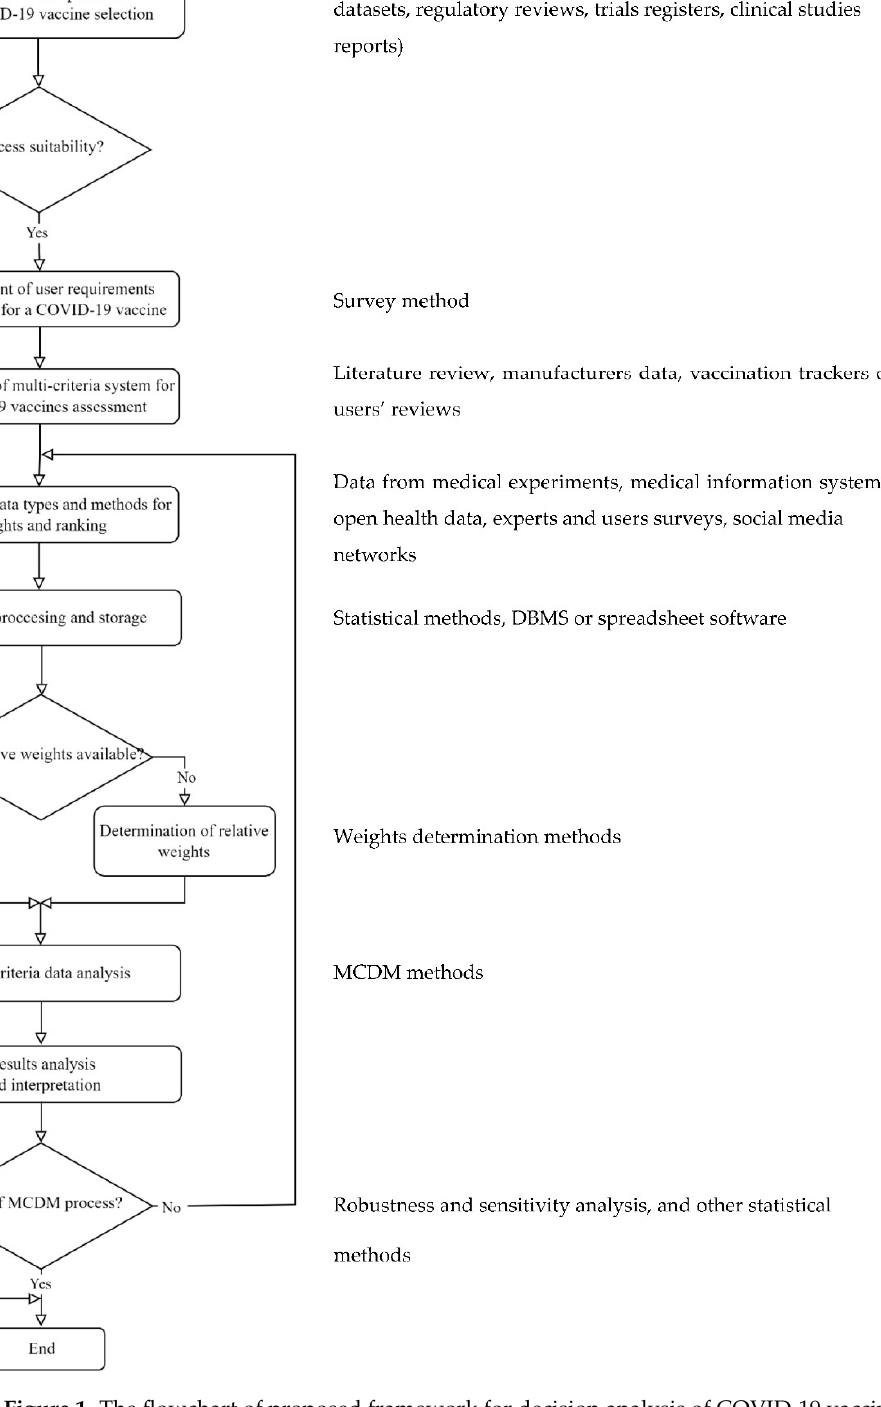
Figure 1. The flowchart of proposed framework for decision analysis of COVID-19 vaccines.